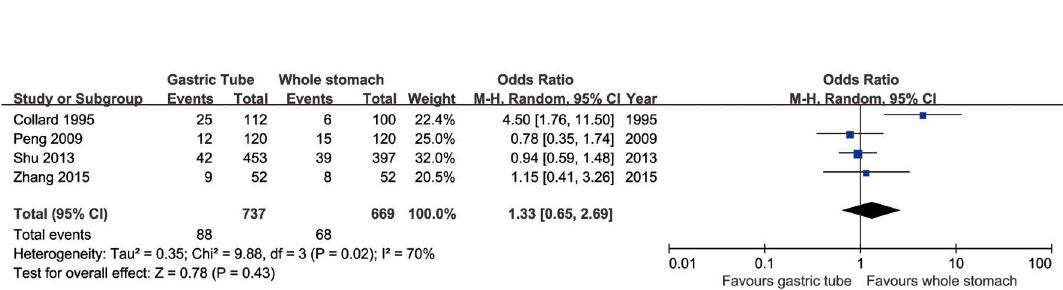
Fig 3. Forest plot of anastomotic stenosis in the whole-stomach and gastric-tube groups.